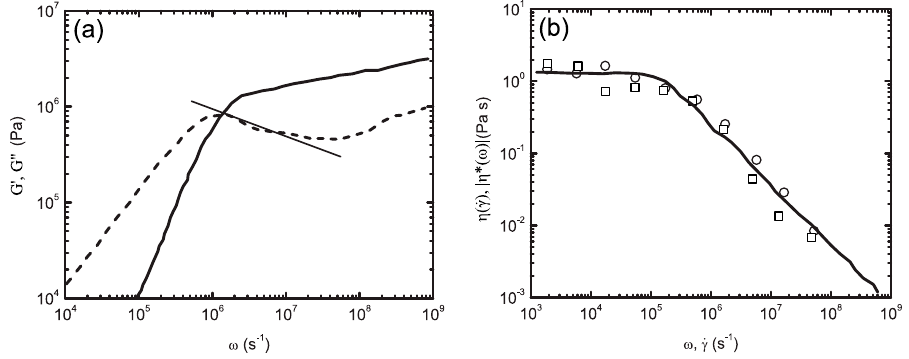
Figure 8. ( a ) Storage G ʹ and loss G ″ moduli (full and dashed lines, respectively); and ( b ) the flow curve for C 800 H 1602 melt at 450 K. Reprinted from Kindt and Briels [404] with the permission of AIP Publishing. The solid line in ( b ) is derived in equilibrium simulations using the Cox-Merz rule. The circles and squares are simulation results under shear benefitting from linear background and variable flow field methods, respectively. For further information regarding the data shown in figure refer to the cited work and the references within it.